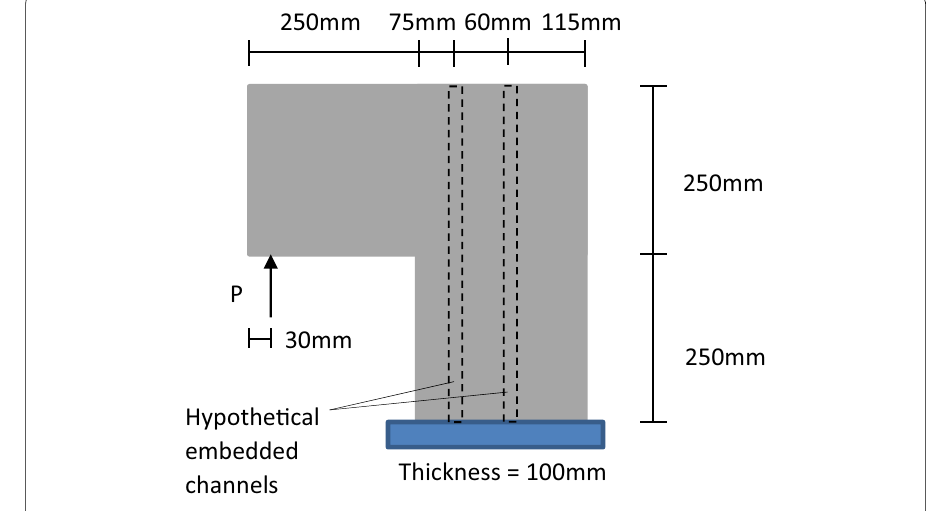
Fig. 11 Schematic of the L beam test set up